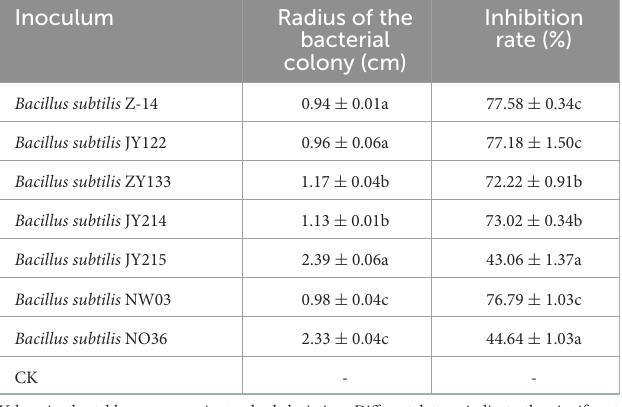
TABLE 1 Inhibition rates of seven bacterial strains against Ggt .